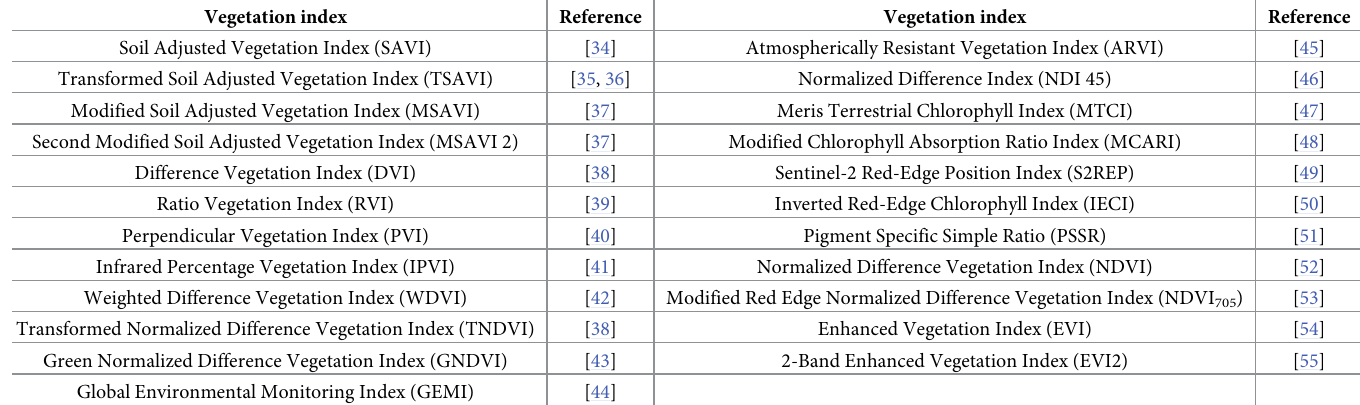
Table 4. Selected vegetation